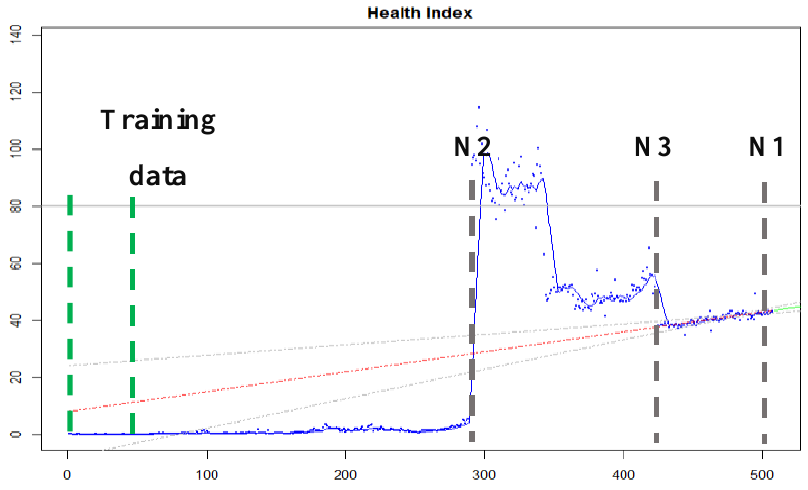
Figure 9. The result of HI without a model update.